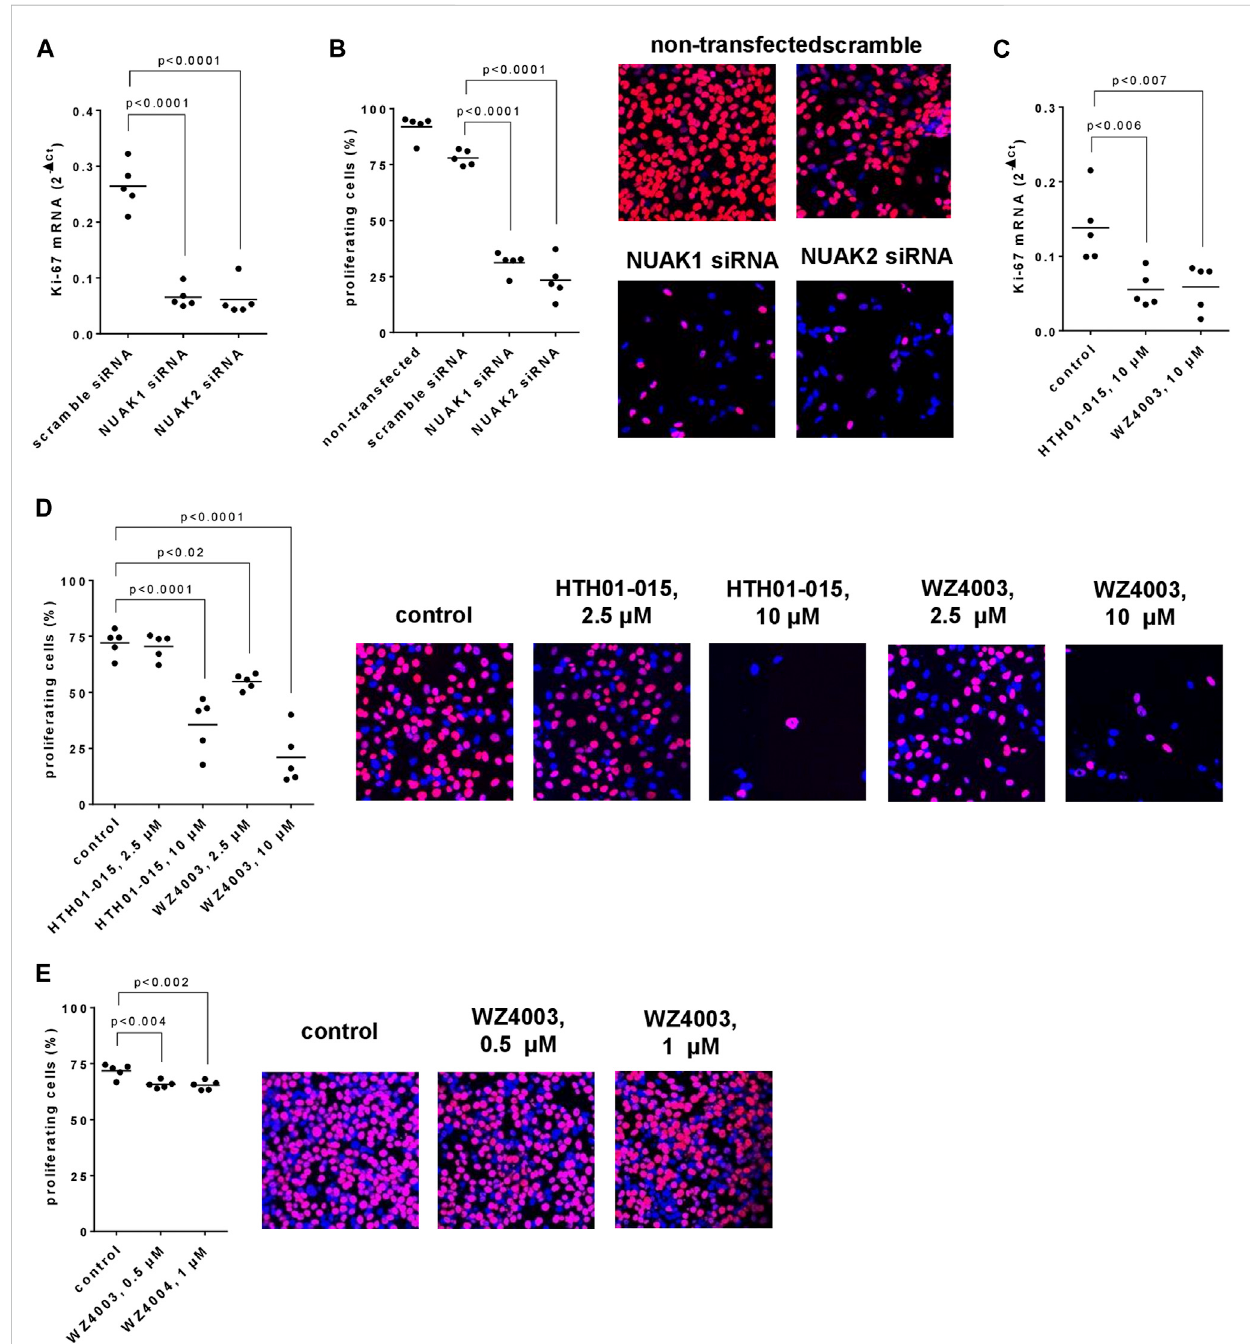
FIGURE 3 Effects of NUAK silencing, HTH01-015 and WZ4003 on proliferation of WPMY-1 cells. Proliferation was assessed 48 h after transfection with scramblesiRNAofisoform-speci fi cNUAKsiRNAs (A,B) ,or36 hafteradditionofHTH01-015,WZ4003orsolventtocontrols (C – E) asthecontentofKi-67 mRNA (A,C) or by EdU assays (B,D,E) . Shown are scatter plots including all single values from each independent experiment together with p values from one-way ANOVA with Tukey ’ s test in (B) and one-way ANOVA with Dunnett ’ s test in all other panels, and representative experiments from EdU